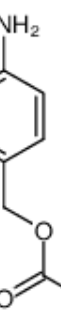
Figure 4. PABC, p-aminobenzyl carbamate, CAS#:918132-66-8.